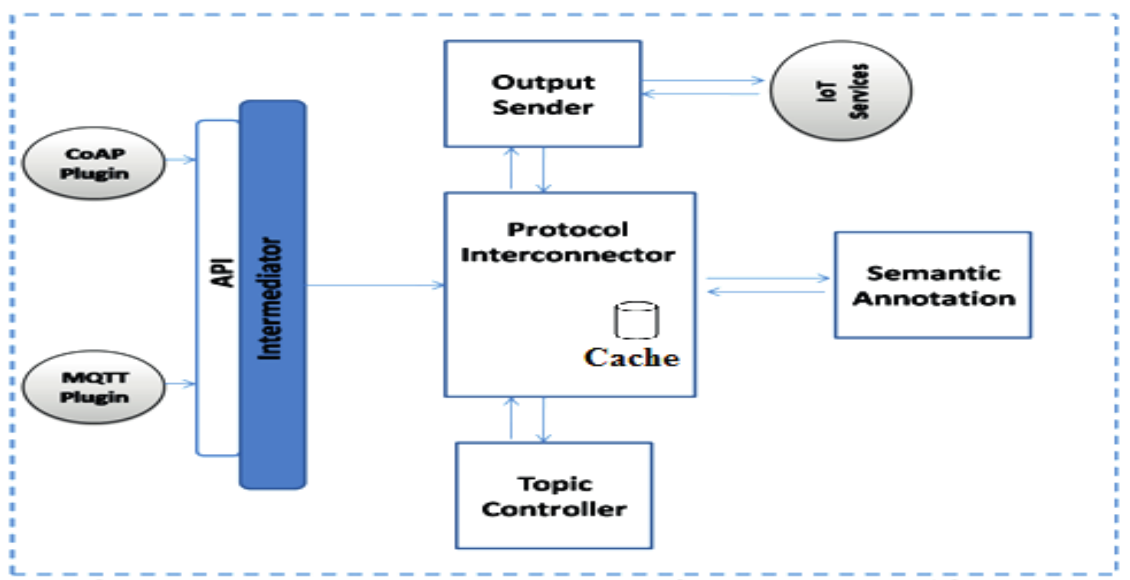
Fig. 1. SGI O T architecture overview.